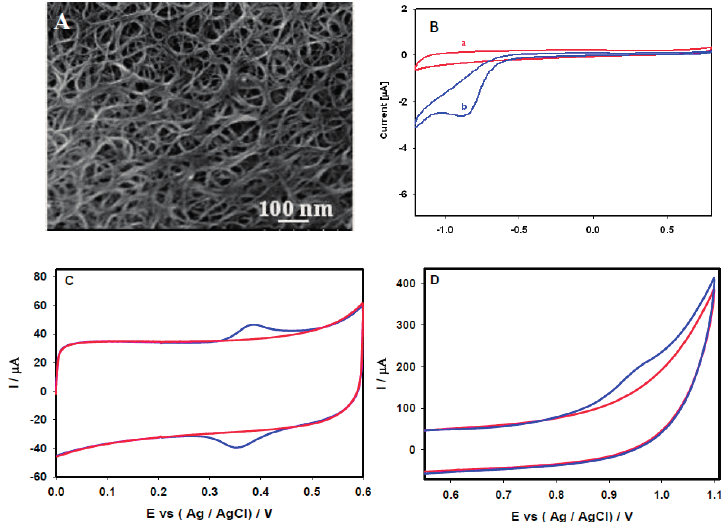
Figure 1. ( A ) FE-SEM images of the SWCNTs on the GCE surface. CV performance recorded at the SWCNT/GCE, in the absence (red solid line), and in the presence of (blue solid line) ( B ) 10 µM methylglyoxal, ( C ) 50 µM acetaminophen, and ( D ) 50 µM valacyclovir, in 0.1 M PBS (pH 7.4) at a scan rate of 20 mV/s. Figure 1B reproduced with permission from [18]. Copyright 2013 Elsevier.